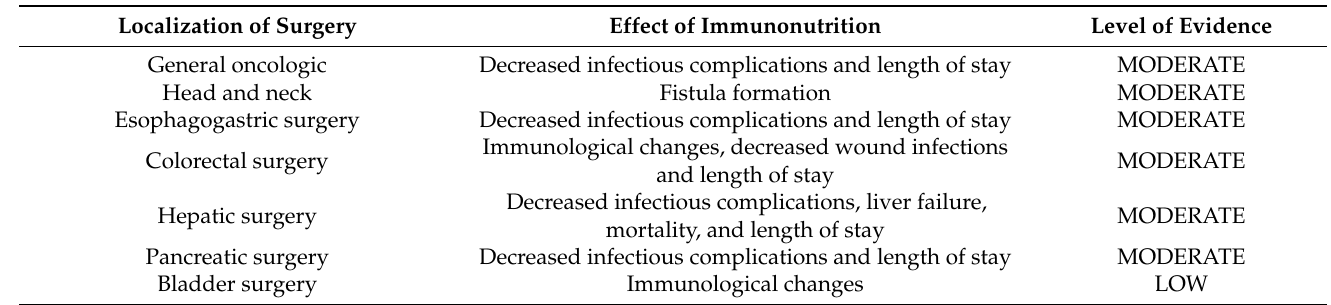
Table 9. Main results of the effects of immunonutrition in review studies based on the function and localization of